Question: Provide a one-line summary of what is displayed.
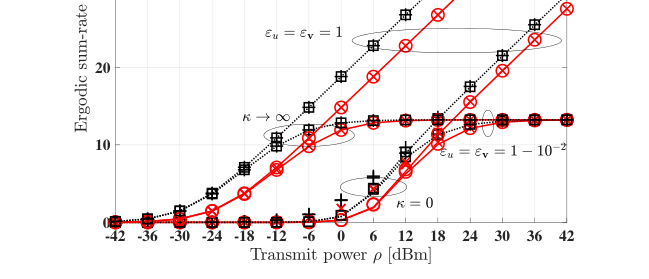
Answer: Theoretical (31), (37) and simulation comparison of the ergodic sum-rate versus the transmit power under different number of IOS elements, hardware quality factor and Rician factor.